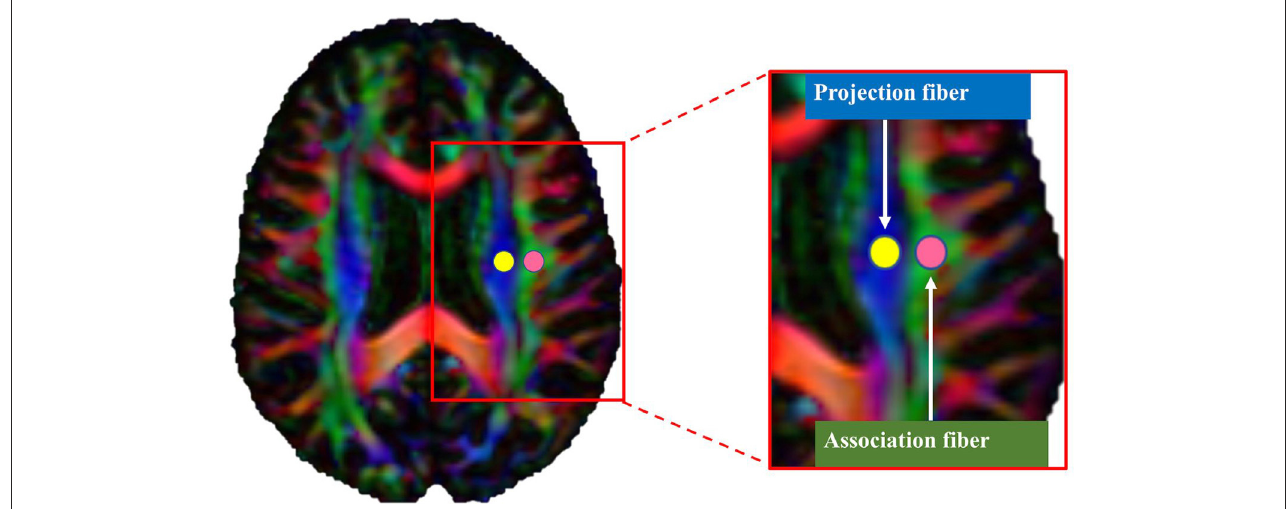
FIGURE1 Region of interest (ROI) placement for calculating the along the perivascular space index. Spherical ROIs measuring 5mm in diameter were placed in the areas of the projection (yellow) and association (pink) fibers.